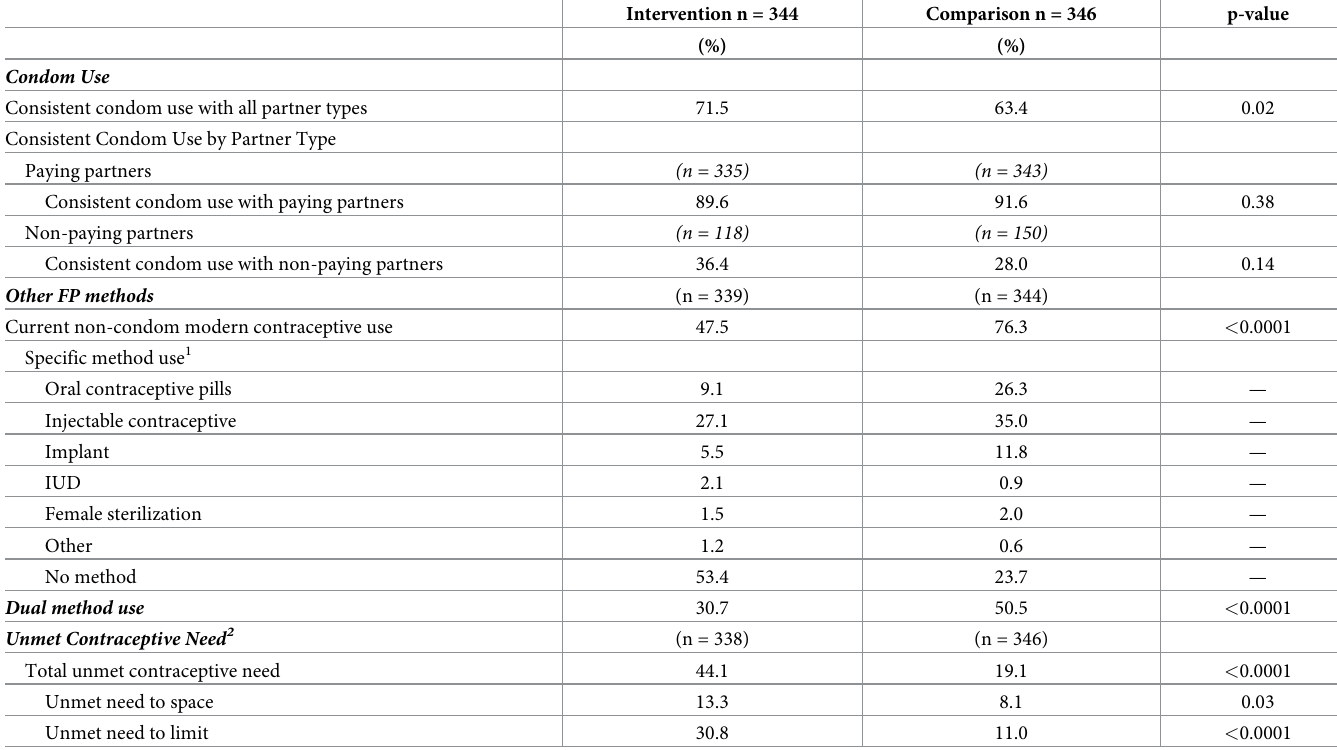
Table 2. Family planning method use and unmet contraceptive need at baseline by study group, among non-pregnant participants. Chi square test use for categorical variables (non-imputed